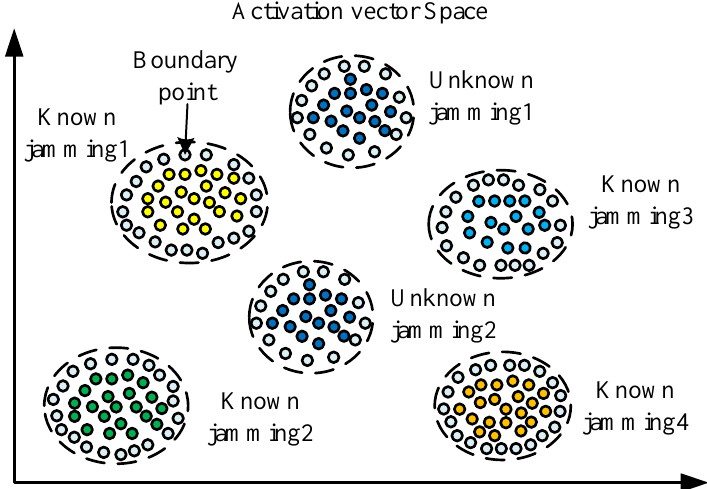
Figure 12. The activation vector space.